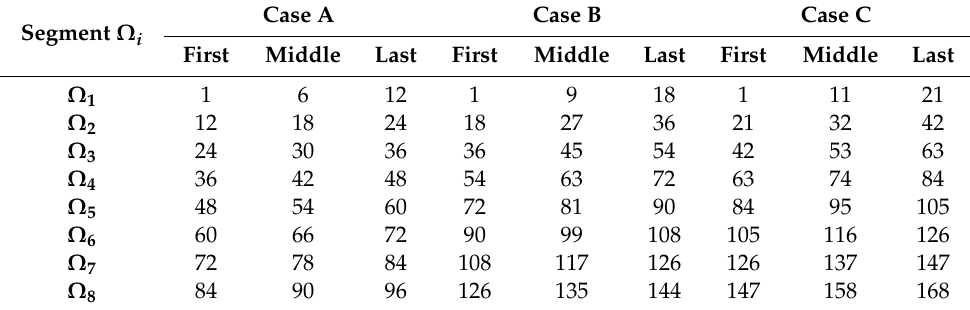
Table 3. The notation of the common projections for eight segments, notation of the common projections of three cases A, B, and C for eight segments Ω i (sparse 12 projections input and the n interp = 96, 144, and